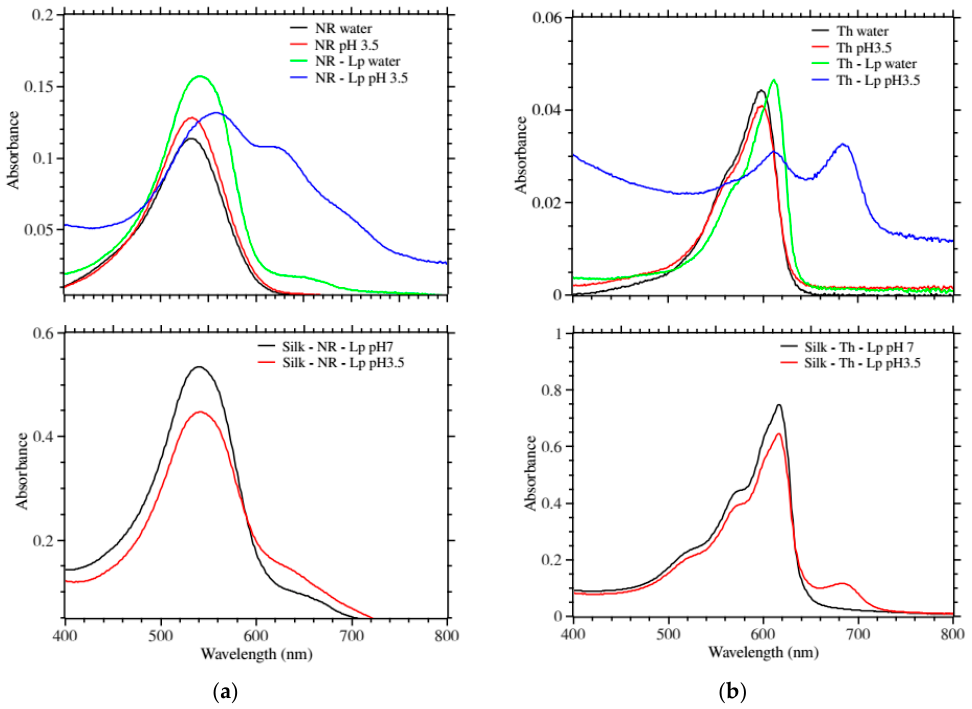
Figure 2. UV-Vis absorbance profiles. ( a ) Top , comparison of free neutral red in water, at pH 3.5; and, neutral red bound to Laponite ® in water and at pH 3.5. With acidification, the Laponite ® modified neutral red displayed new red peaks; Bottom , comparison of silk patches containing neutral red and Laponite ® at pH 7 and pH 3.5. The main peak intensity decreased and a new red peak appeared; ( b ) Top , comparison of free thionine in water and at pH 3.5; and thionine bound to Laponite ® in water and at pH 3.5. With acidification, the Laponite ® modified thionine displayed strong new red peaks; Bottom , comparison of silk patches containing thionine and Laponite at pH 7 and pH 3.5. The main peak intensity decreased and a new stronger red peak appeared.